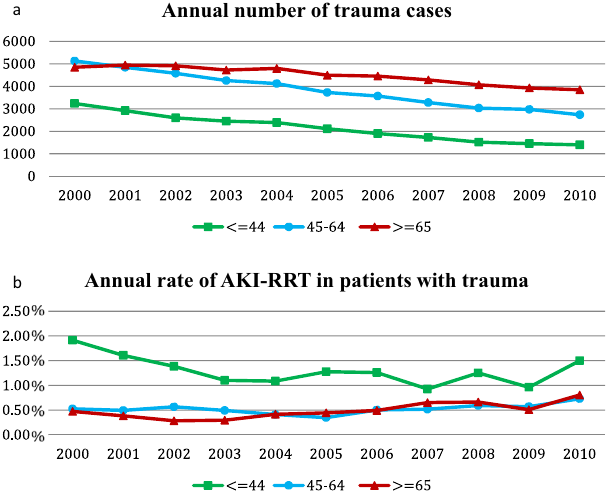
Figure 2. Temporal patterns of annual number of trauma cases ( a ) and annual rate of vehicle-traumatic AKI-RRT ( b ) stratified by age groups (annual rate of vehicle-traumatic AKI-RRT = annual number of vehicle- traumatic AKI-RRT/ annual number of trauma cases). ( b ) p for trend, age ≦ 44: 0.073, 45 < age < 65: 0.183, age ≧ 65: 0.004).